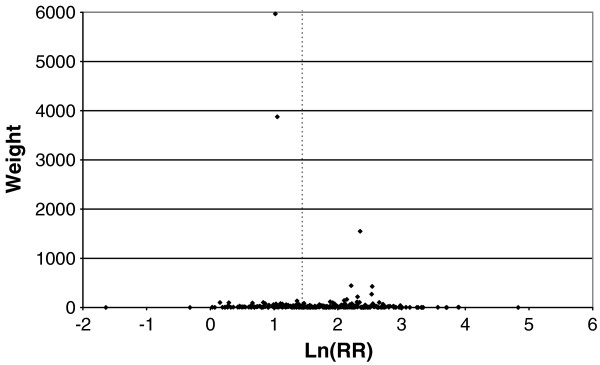
Funnel plot for ever smoking and all lung cancer. Funnel plot of the 328 relative risk estimates for ever smoking and all lung cancer included in the main meta-analysis in Table
5 against their weight (inverse-variance of log RR). The dotted vertical line indicates the fixed-effect meta-analysis estimate.